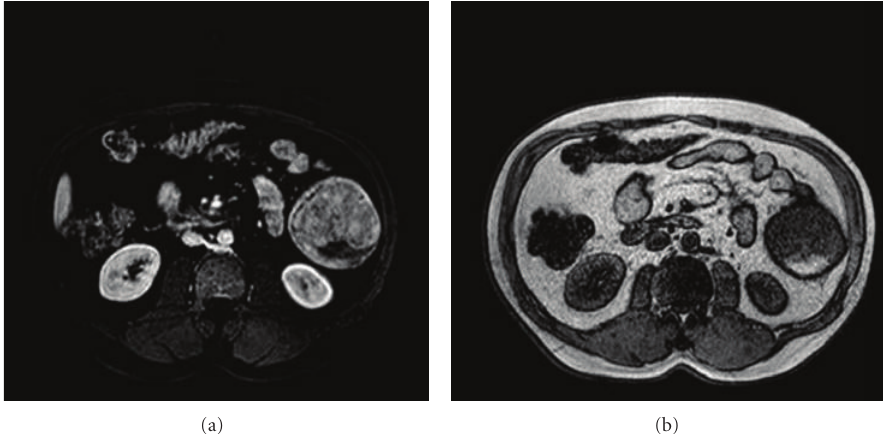
Figure 1: (a) Intense contrast enhancement of splenic mass. No enhancement detected at the inferior side suggesting bleeding. (b) MRI: regular-bordered mass with heterogenic hyperintense area at inferior pole on axial T1 weight pulse sequence.